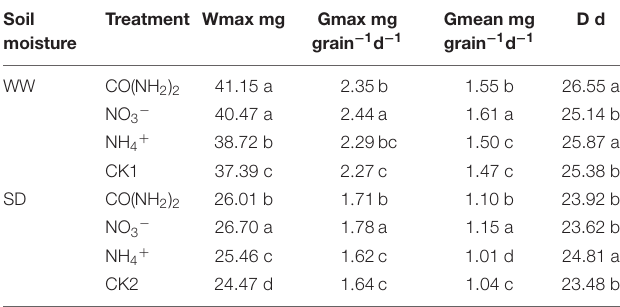
TABLE 1 | Effect of N forms in foliar fertilizer on grain filling characteristics of wheat. Soil Treatment Wmax mg moisture